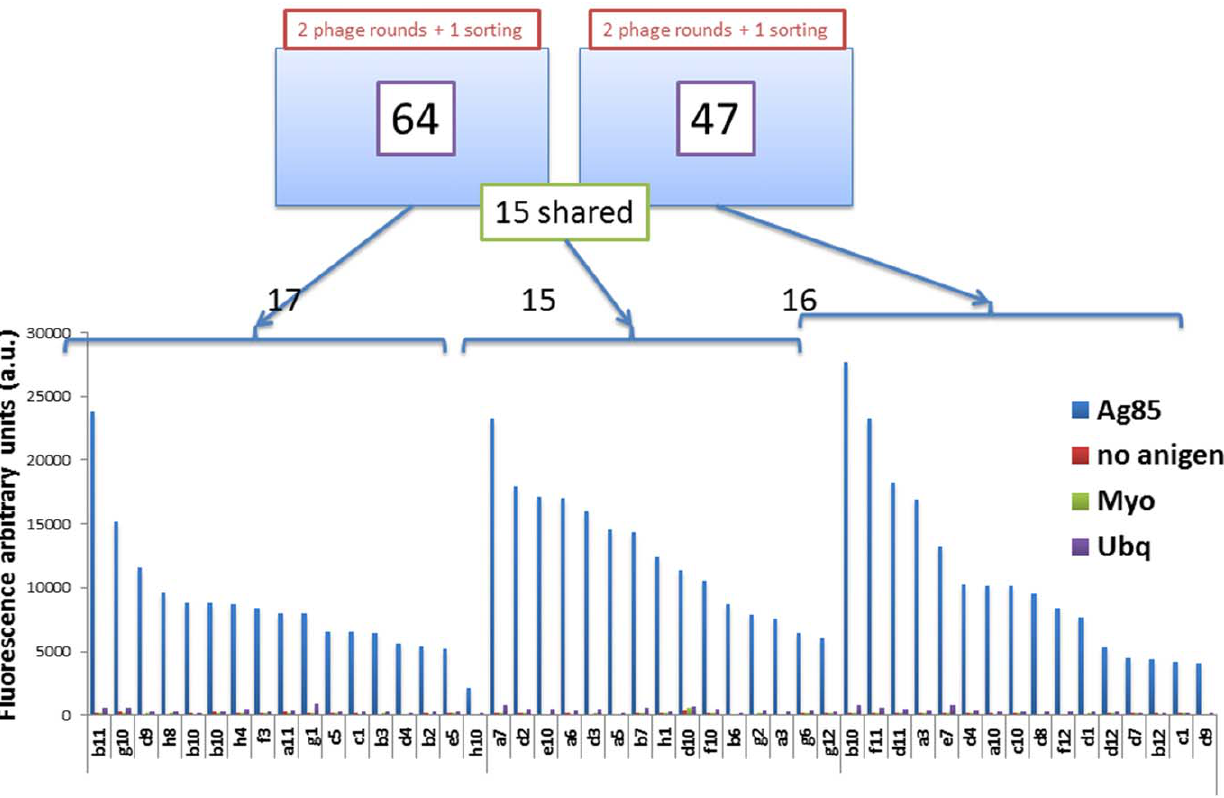
Figure 3. Specificity of selected monoclonals. 48 different monoclonals chosen from among the 111 identified were tested for specific binding to Ag85, as well as two irrelevant antigens (myoglobin and ubiquitin). All were positive for Ag85, showing signal to noise ratios exceeding 8.